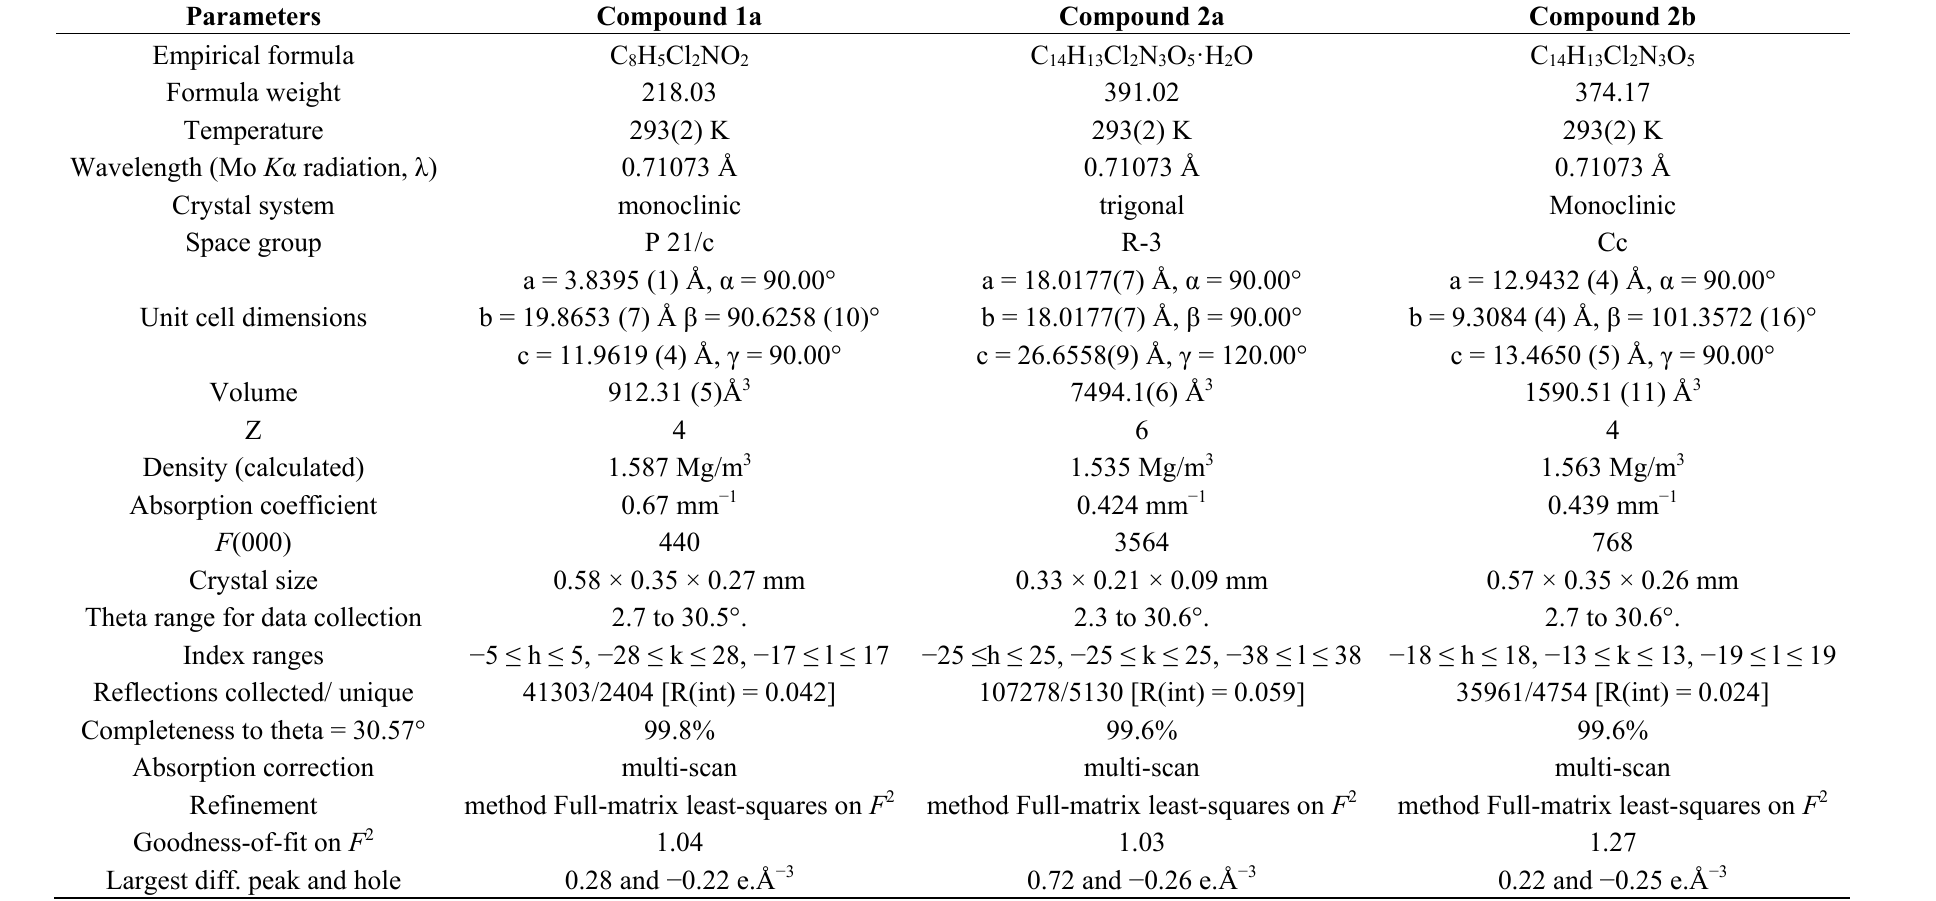
Table 1. Crystal and experimental data of compounds 1a , 2a and 2b